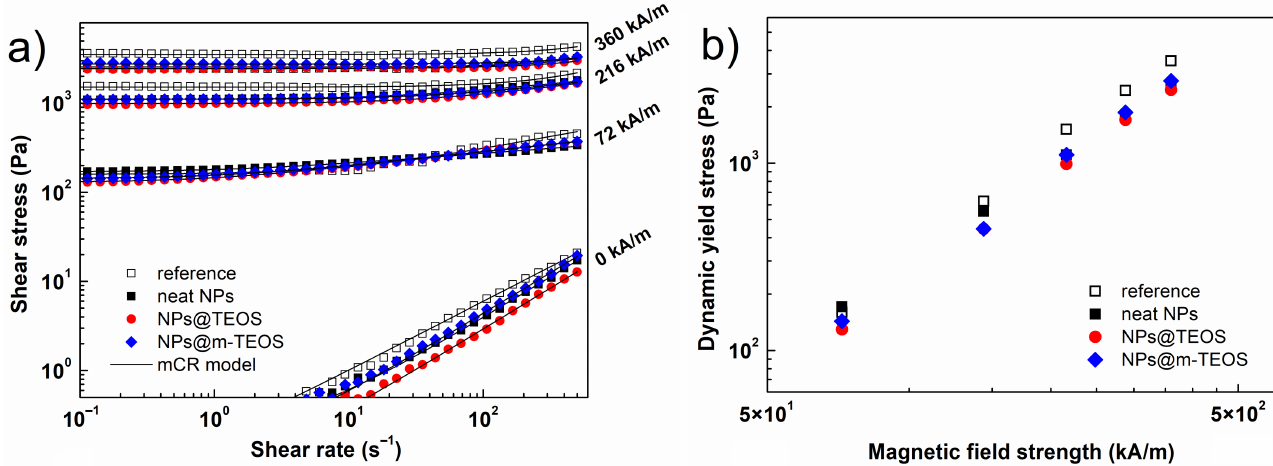
Figure 6. Shear stress as a function of shear rate ( a ), and the dynamic yield stress as a function of magnetic field strength ( b ) for the reference MR fluid (white squares), and its bidisperse analogues supplemented with the neat NPs (black squares), NPs@TEOS (red circles) and NPs@m-TEOS (blue